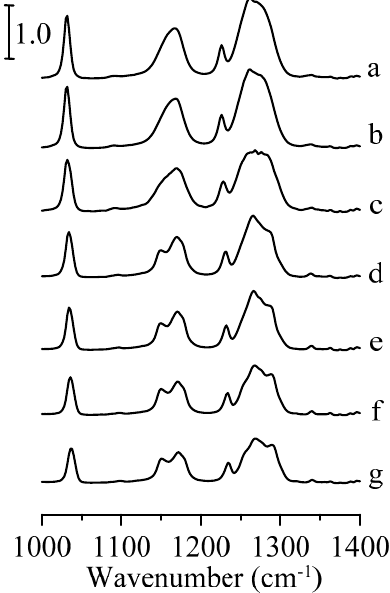
Figure 8. Infrared spectra of Al 2 O 3 /1-ethyl-3-methylimidazolium trifluoromethanesulfonate mixture obtained under ambient pressure (curve a) and at 0.4 (curve b), 0.7 (curve c), 1.1 (curve d), 1.5 (curve e), 1.8 (curve f), and 2.5 GPa (curve g).